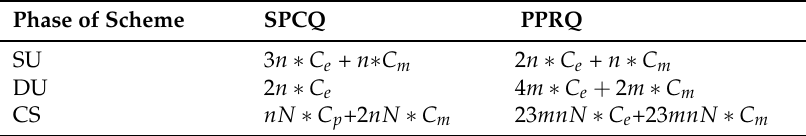
Table 2. Comparison of computation complexity.